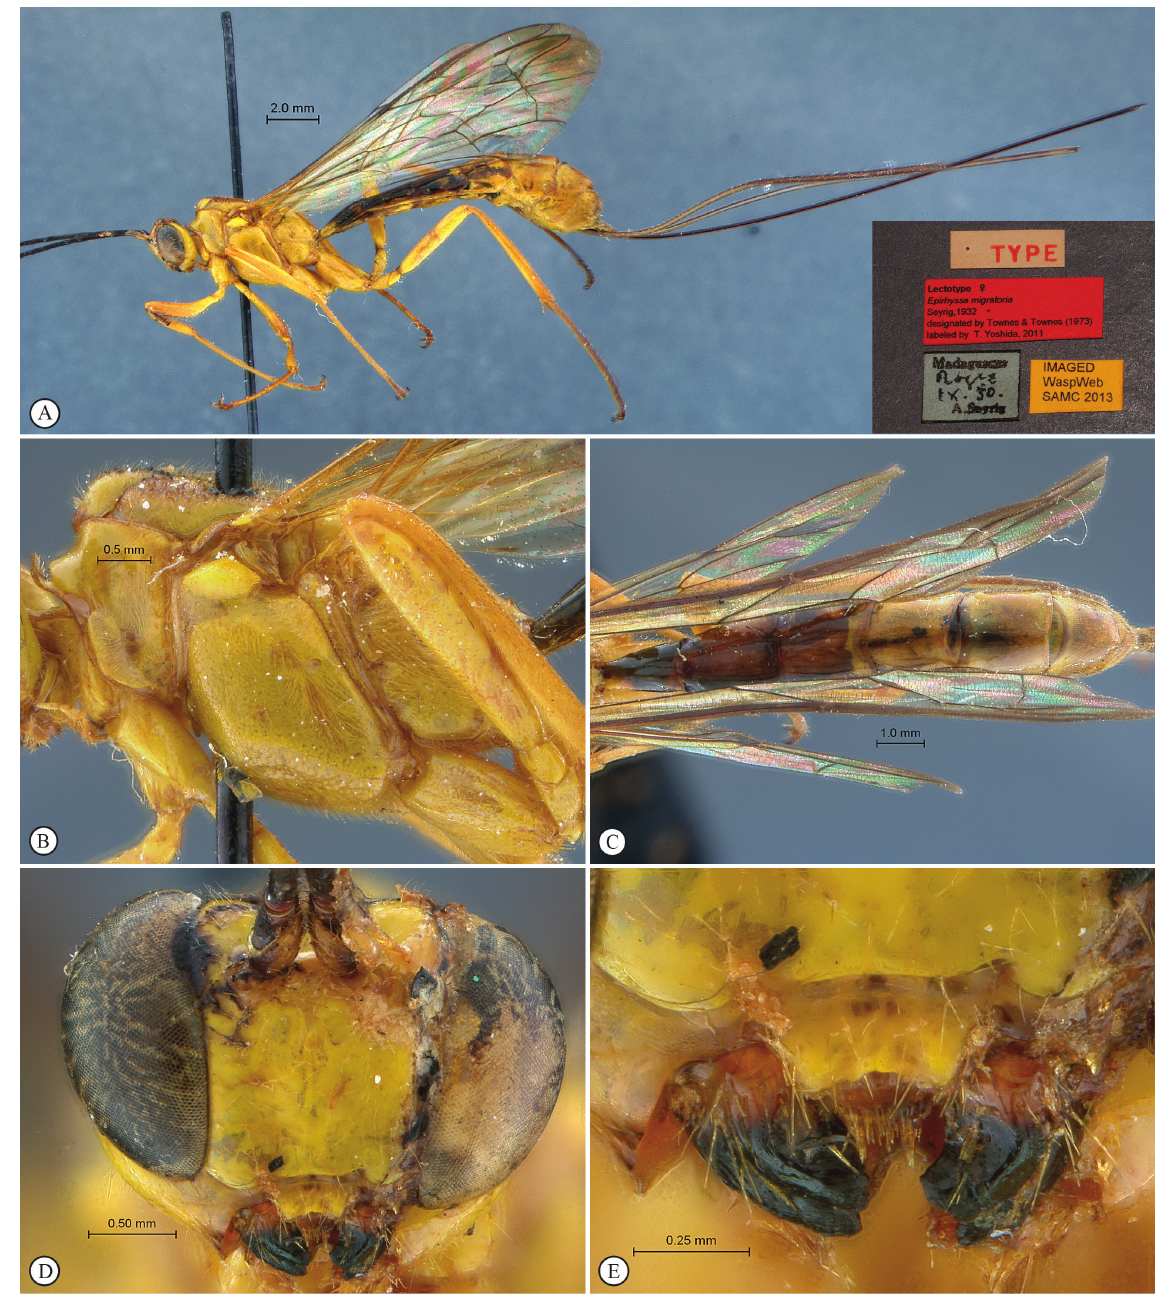
Fig. 6. Epirhyssa migratoria Seyrig, 1932, holotype, ♀. A . Habitus, lateral view (inset: data labels). B . Mesosoma, lateral view. C . Metasoma, dorsal view. D . Head, anterior view. E . Mandibles, anterior